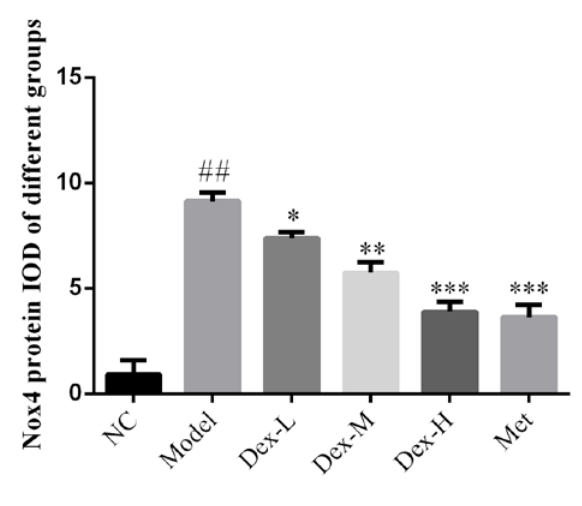
Figure 9: Comparison of p-MYPT protein expression in Kidney of Rats in Each